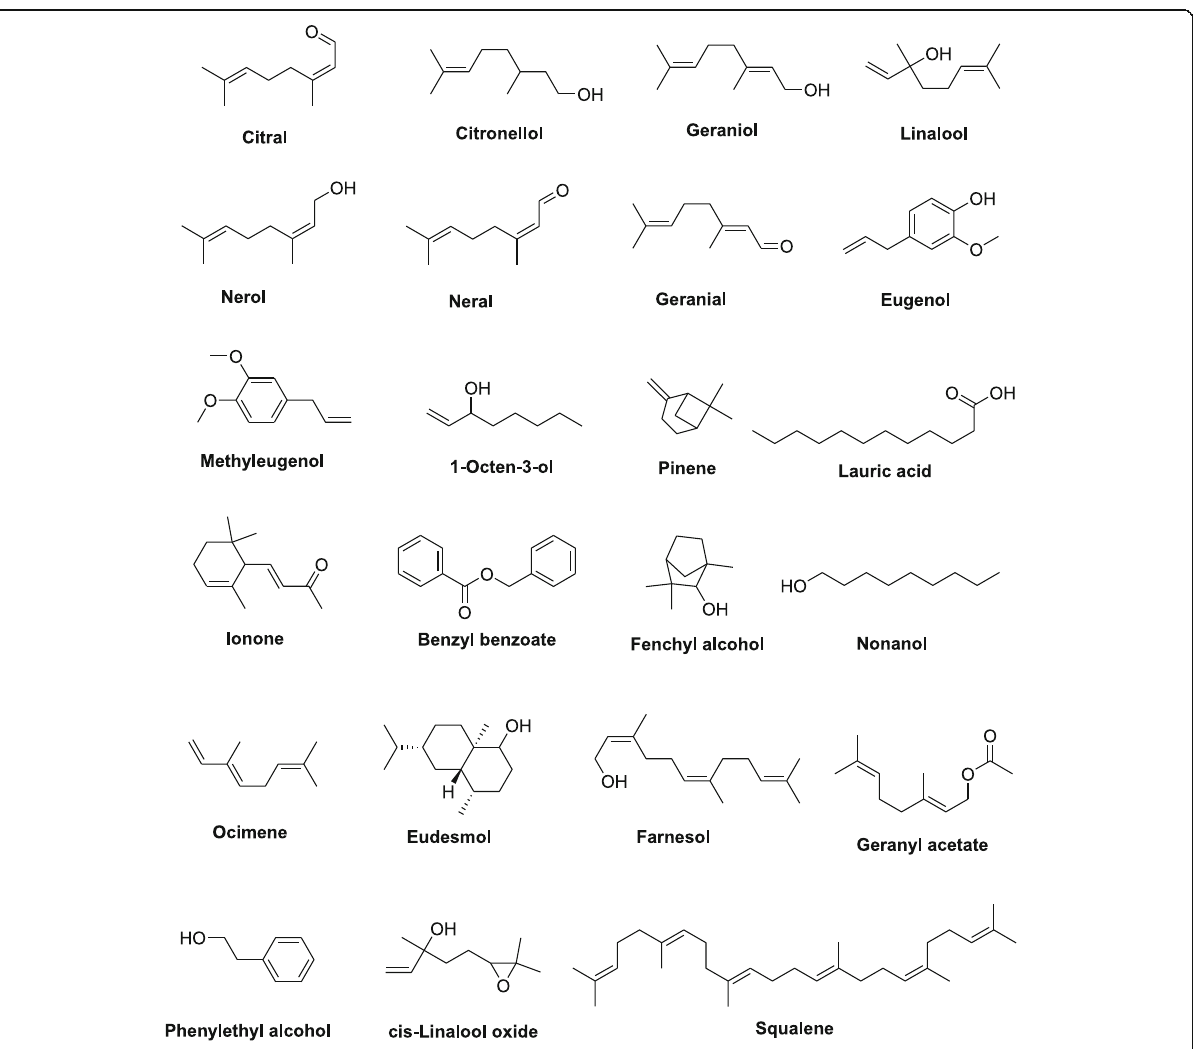
Fig. 1 Chemical structures of some compounds reported in Rosa alba